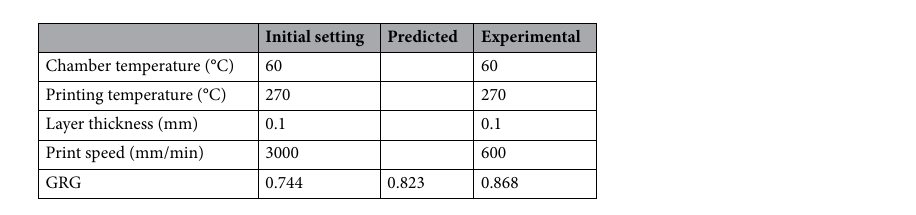
Table 12. Measured values of